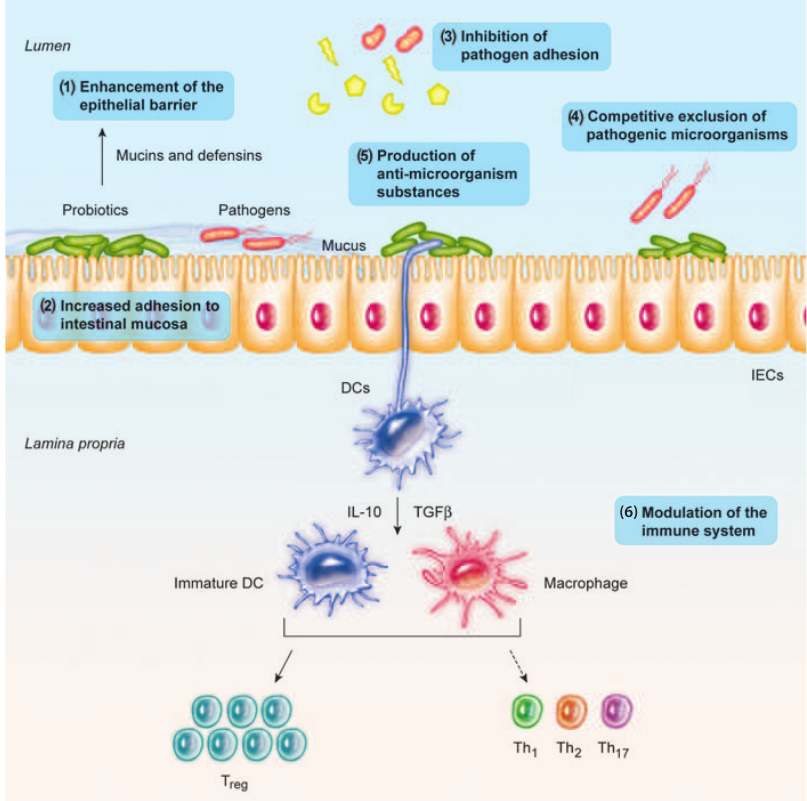
Figure 1. Main mechanisms of action of probiotics